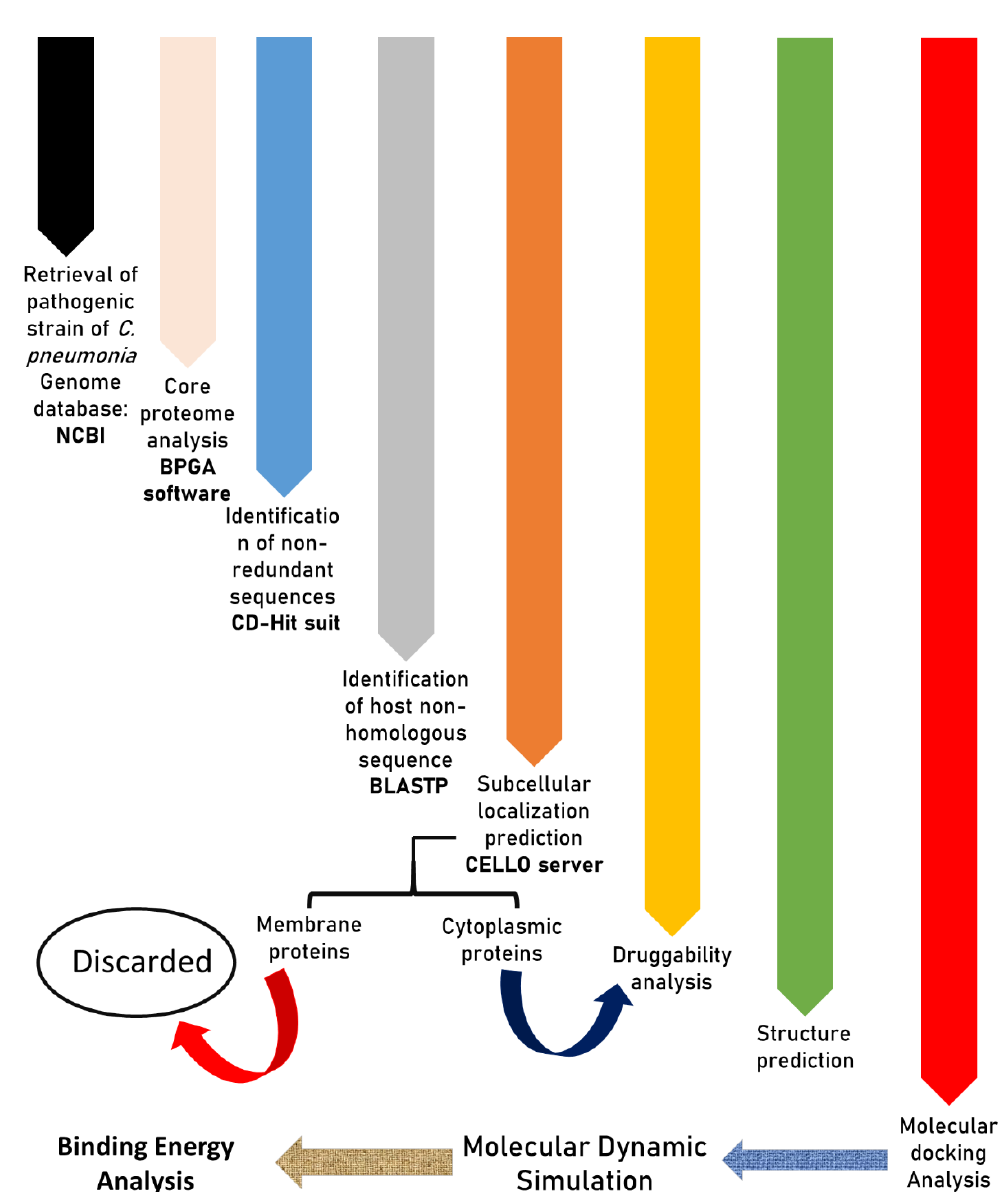
Figure 1. Graphical synopsis representing the overall methodology used in the current analysis.